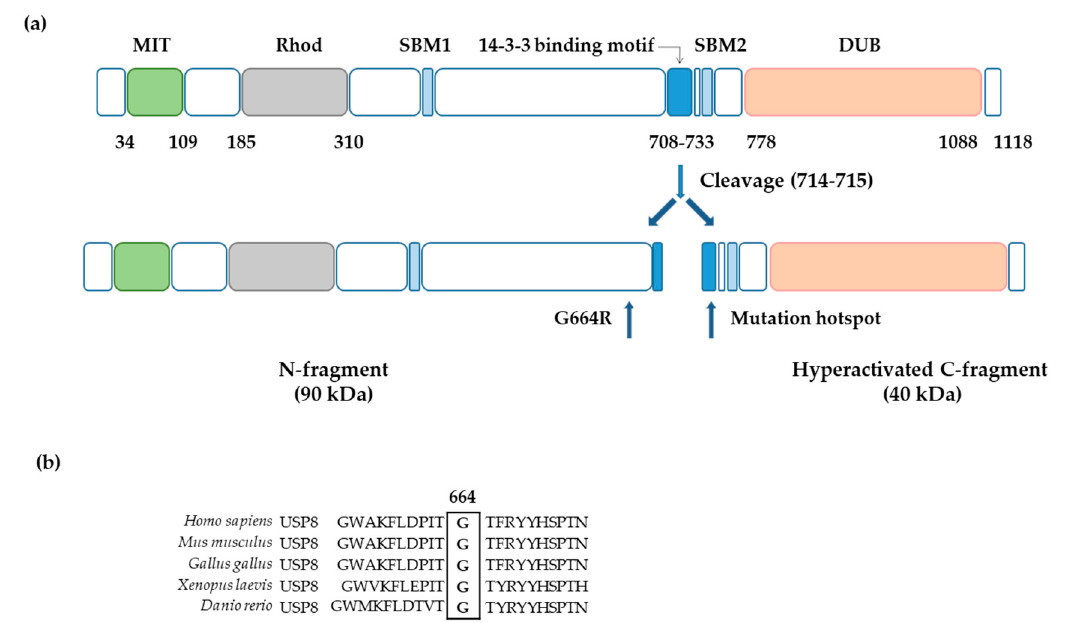
Figure 1. Identification of a novel USP8 somatic variant in ACTH-secreting pituitary tumors. ( a ) The novel USP8 G664R variant is located upstream the USP8 mutational hotspot (amino acid 713-720). Human USP8 functional regions: MIT domain (MIT); rhodanese-like domain (Rhod); SH3-binding motif (SBM); 14-3-3 binding motif (14-3-3); and deubiquitinase catalytic domain (DUB) . ( b ) Homology alignment of USP8 amino acidic sequence: the boxed glycine at residue 664 is highly conserved between vertebrate species.